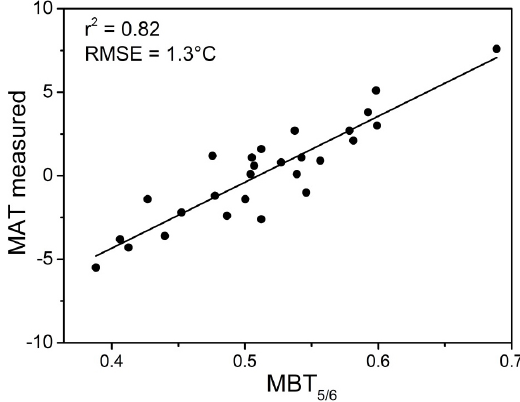
Figure 7. Linear regression plot of MBT 5 / 6 versus MAT in the